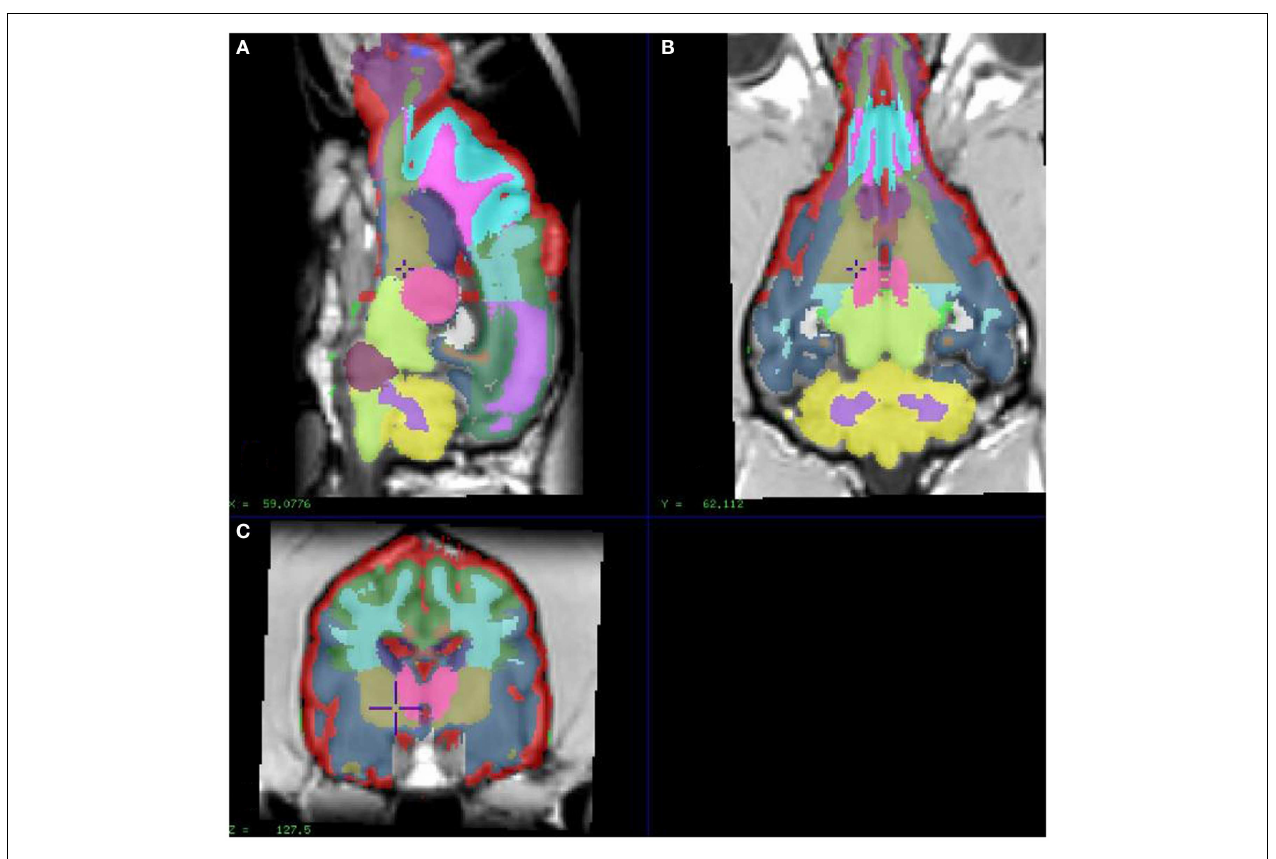
of dog brain at the level of the third ventricle and caudate nucleus with identification of ROI. (C) Transverse section of dog brain at the level of the third and lateral ventricles and the habenular nucleus with identification of ROI. Color code identifies the gray matter for each ROI used. ROI, regions of